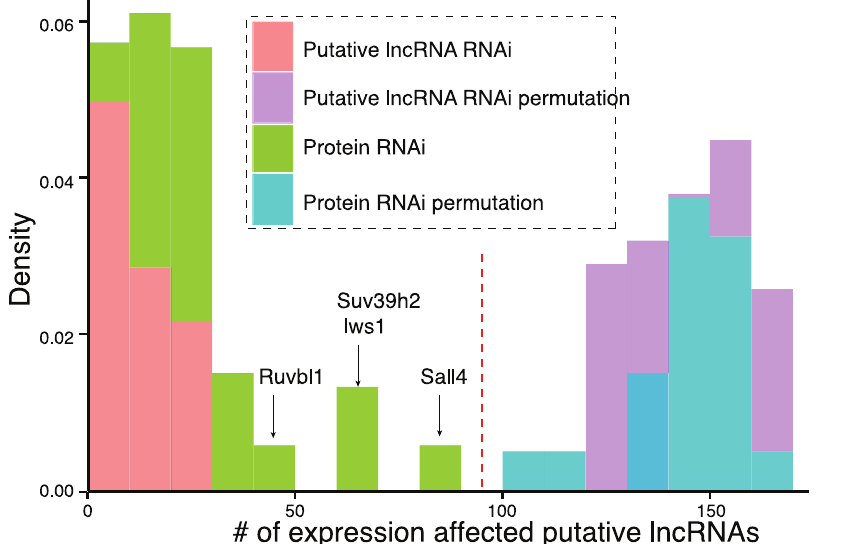
Figure 7. Distribution of putative embryonic brain lncRNAs and permutated lncRNAs with affected expression upon RNA interference of 226 lncRNAs and 40 regulatory proteins based on a published microarray data. Microarray probes aligned to putative embryonic brain lncRNAs by comparing genomic coordinates are used to explore the expression alteration of putative lncRNAs by comparing microarray profiles of RNA interference of 226 lncRNAs (and 40 regulatory proteins) and controls. The thresholds of 95th percentile and 5th percentile of ranked overall control expression in control profiles are used to obtain up- and down-regulated lncRNAs, respectively. Up-regulation and Down- regulation of putative lncRNAs are not separately analyzed for putative embryonic brain lncRNAs with altered expression. We observe that the distribution of putative embryonic brain lncRNAs with altered expression by RNA interference is separated from putative embryonic brain lncRNAs with altered expression by control interference by Red dash line.